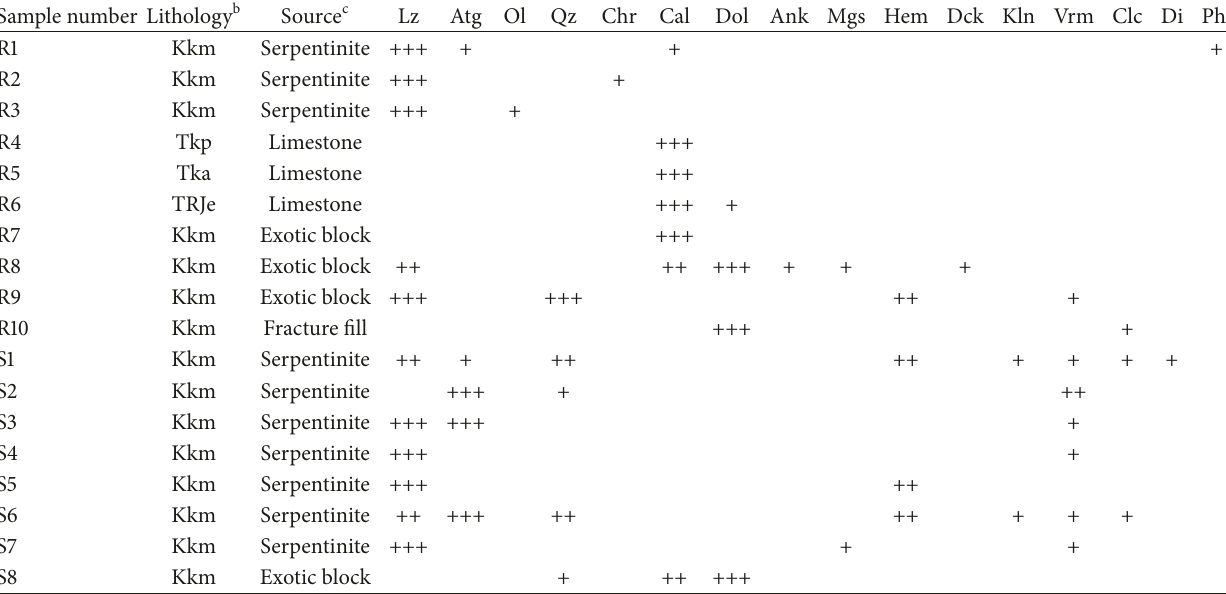
Table 1: Mineralogical composition of the selected rock (R1–R10) and soil (S1–S8) samples from the Kızılgedik area as determined by X-ray diffraction (XRD) analysis a